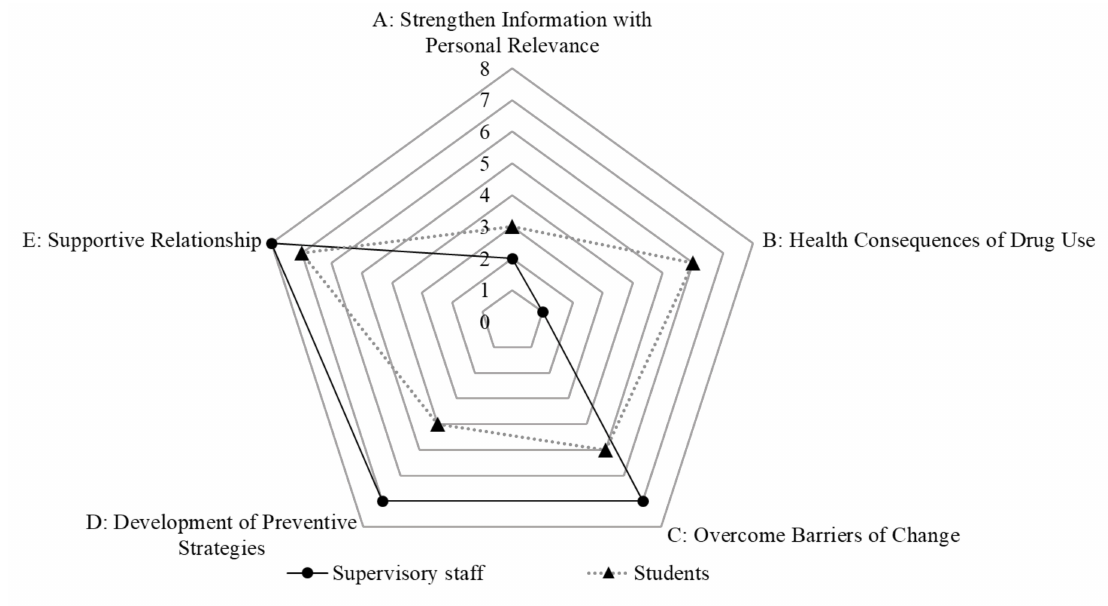
Figure 2. A glance at the similarities and di ff erences between the perspectives of supervisory sta ff and supervisory sta ff by using a radar chart. The marks represent the number of characterizing statements for each category and indicated the degree of categories which were endorsed by the supervisory sta ff and